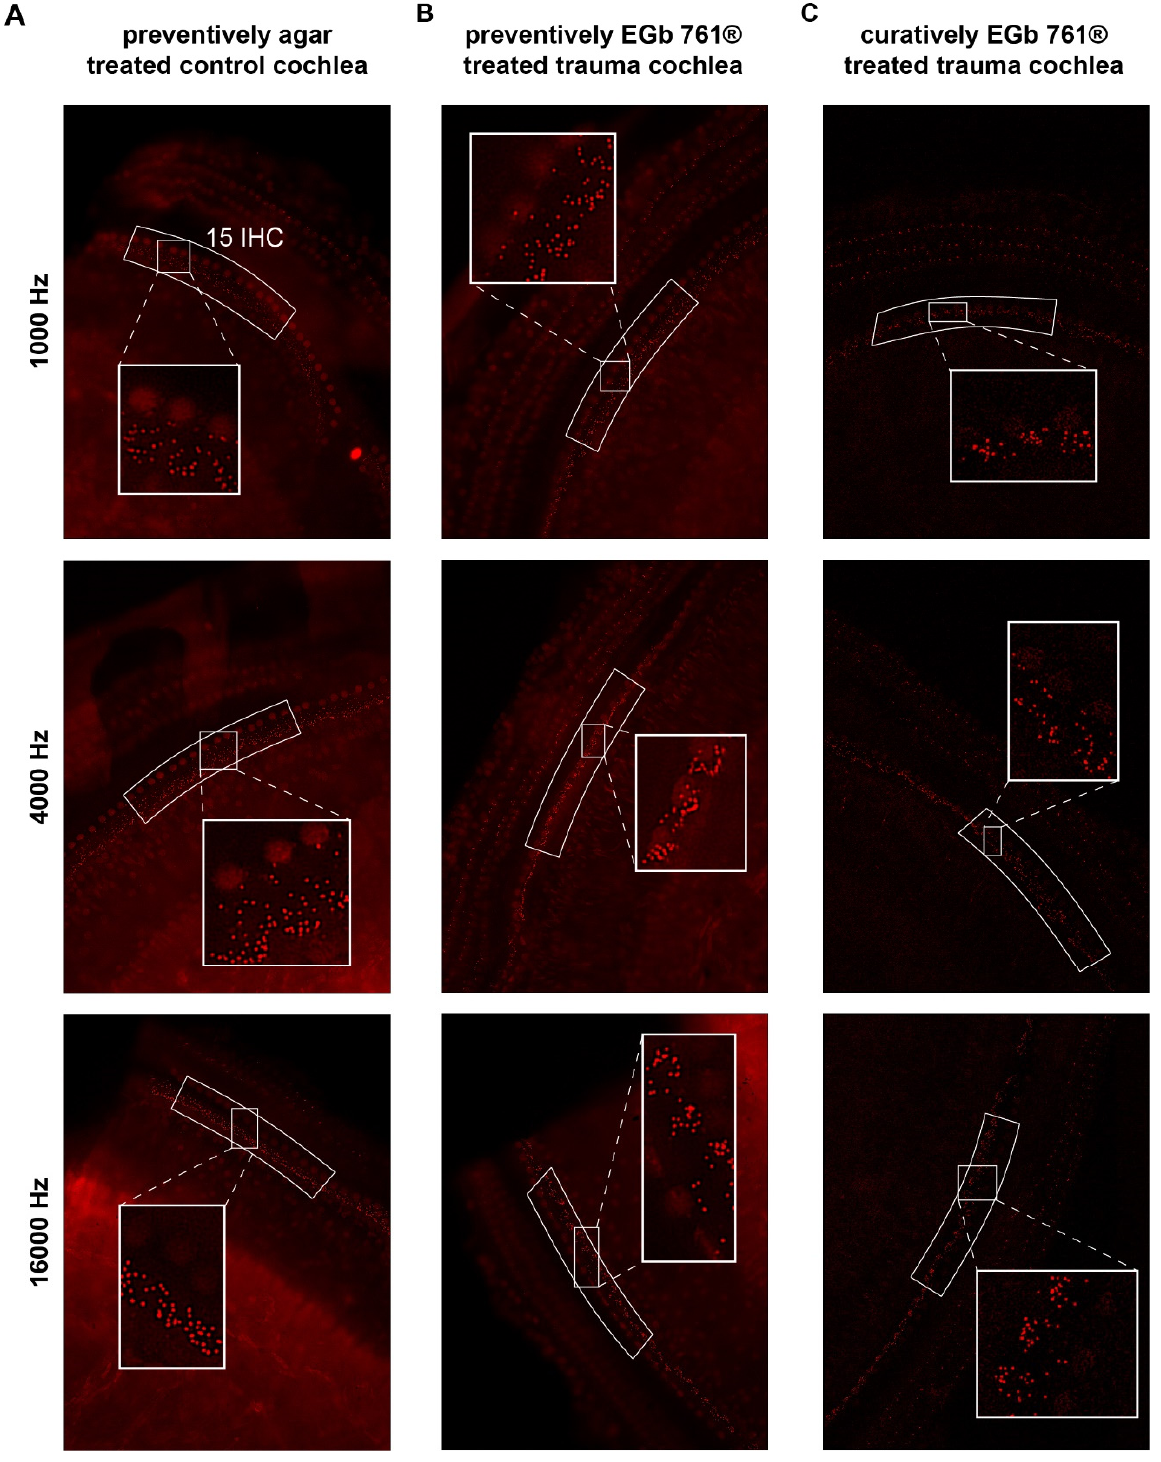
Figure 2. Exemplary immunostained histological slices of three different animals’ cochleae. ( A ) Slices of a preventively agar-treated control cochlea. Given are the tonotopic locations of 1000 Hz (top), 4000 Hz (center) and 16,000 Hz (bottom) with the 15 evaluated IHCs marked in the white arc-box. The insets show a zoom on three of the IHCs with the ribbon synapses in red. ( B ) Slices of a preventively EGb 761 ® -treated trauma cochlea. ( C ) Slices of a curatively EGb 761 ® -treated trauma ear.